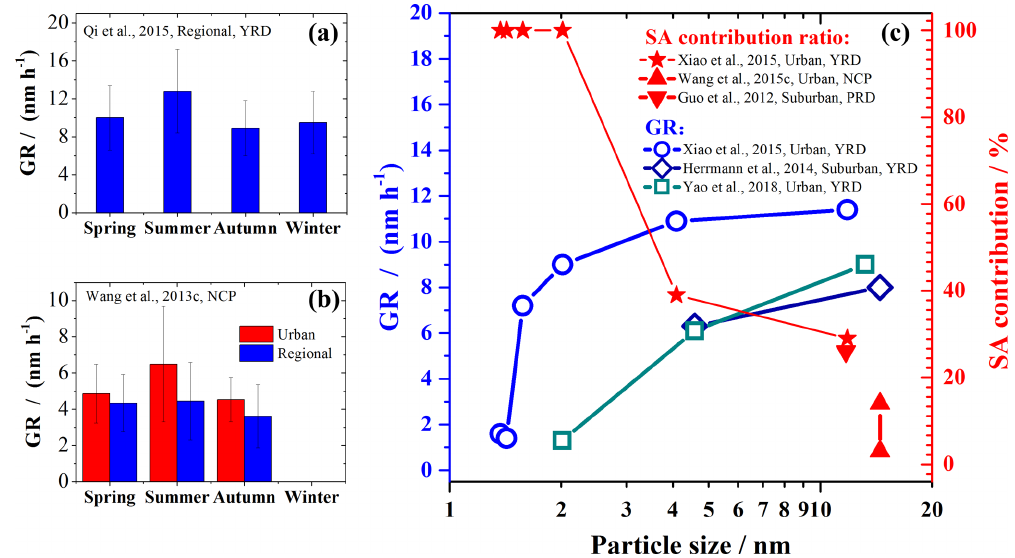
Figure 4. Particle GR observed in different seasons at a regional site in the YRD (a) and an urban and a regional site in the NCP (b) and some measurement results of GR and sulfuric acid (SA) contribution to the GR in different size ranges (c) . The data are collected in the references indicated in the